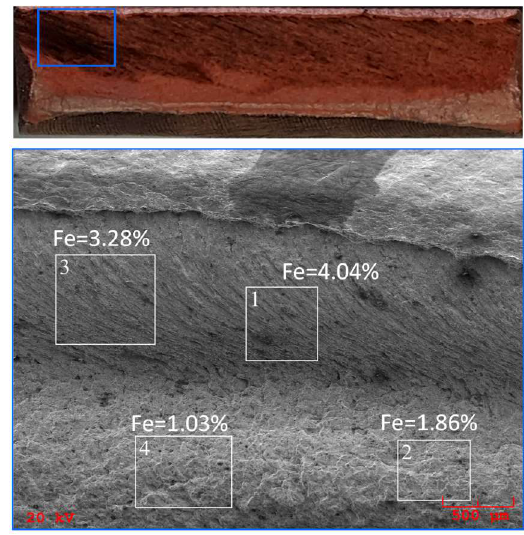
Figure 11. The fracture surface of the FSW80-L1 sample, showing areas of EDS analysis and iron content.